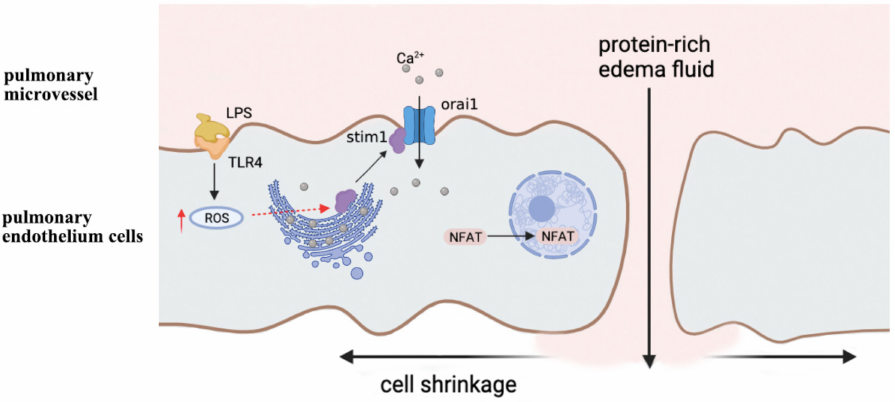
Figure 2. Calcium oscillations and endothelial dysfunction during acute lung injury. LPS: endotoxins; TLR4: toll-like receptor 4; ROS: reactive oxygen species; stim1: stromal interaction molecule 1; Orai1: calcium release-activated calcium modulator 1; NFAT: nuclear factor of activated T